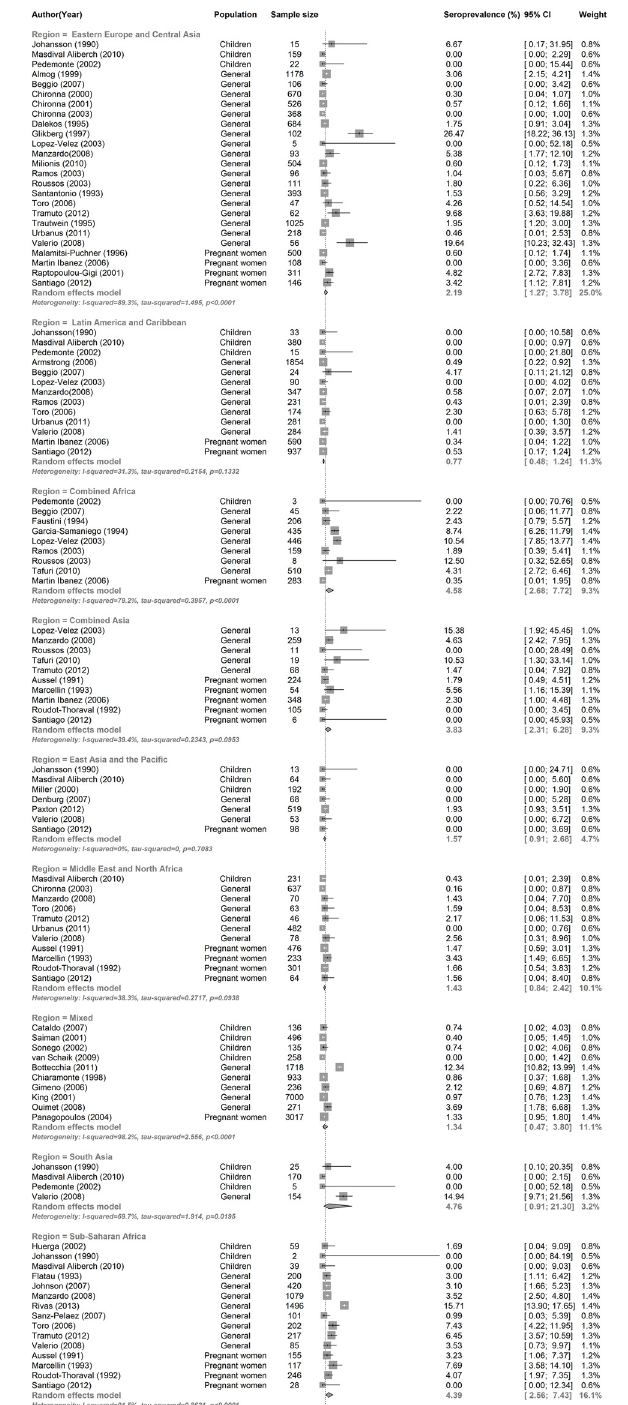
Fig 3. HCV seroprevalence for all included studies stratified by migrants region of origin (Forest Plot).